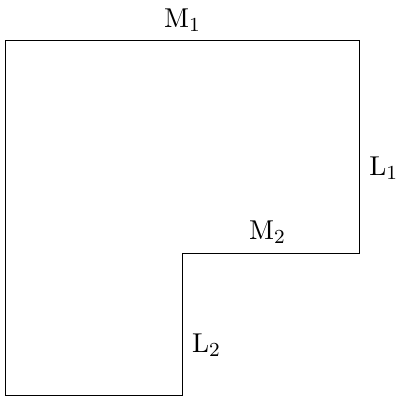
Figure 21 . Young tableau corresponding to the reference state j (cid:3) i